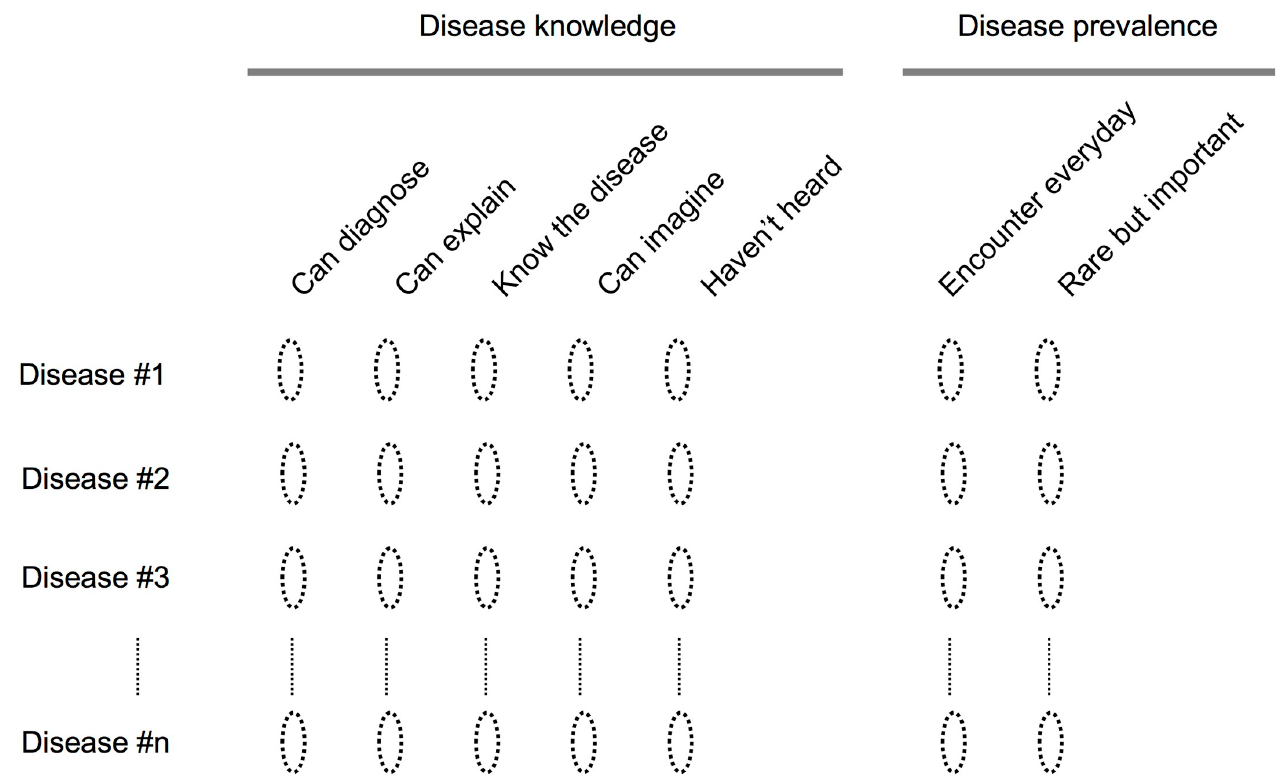
Fig 3. Self-assessment